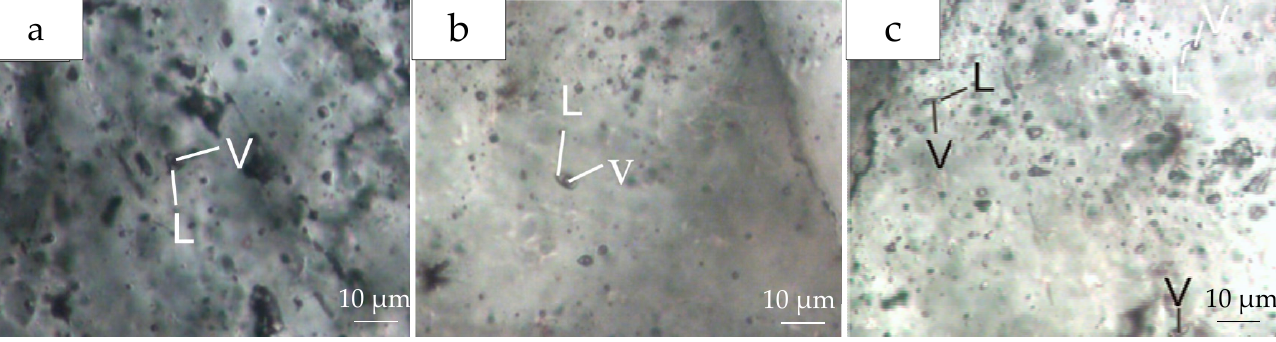
Figure 7. Photomicrograph of fluid inclusions in quartz from Stages I ( a ), II ( b ), and III ( c ) in Xiaojiashan gold deposit. Table 4. Temperature of fluid inclusions in Xiaojiashan gold deposit.